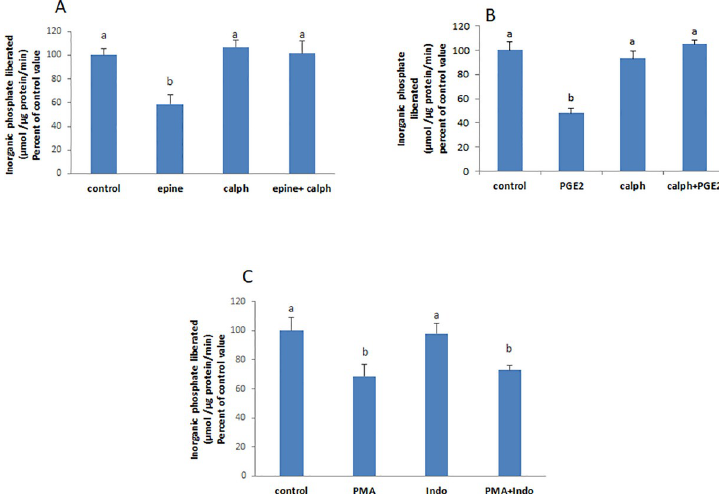
Fig 3. Epinephrine and PGE2 activate PKC. The effect of the ( A) hormone and the (B) prostaglandin disappeared in presence of calphostin (50 nM), an inhibitor of PKC while (C) PMA, an activator of the kinase, exerted a significant inhibitory effect on the ATPase that was maintained in presence of indomethacin, an inhibitor of COX enzymes. Values are means ± SEM of at least 3 observations. Bars not sharing a common letter are considered significantly different from each other at P < 0.01.